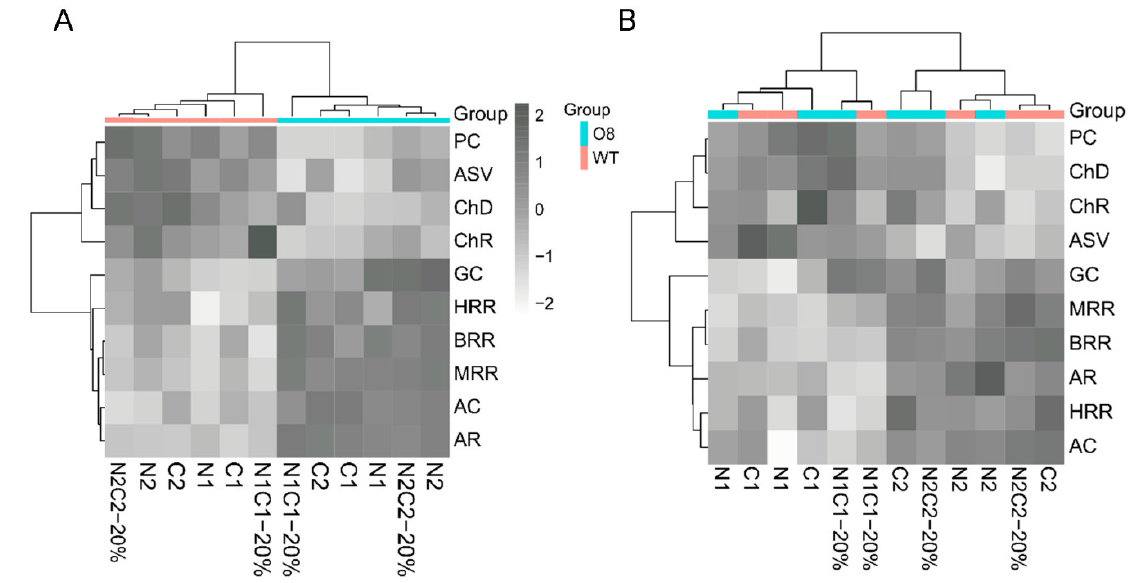
Figure 6. Hierarchical clustering of quality indicators of O8 and WT under different fertilizer treatments. Hierarchical clustering of quality indicators of O8 and WT under different fertilizer treatment in 2019 ( A ) and 2020 ( B ). BRR, brown rice rate; MRR, milling rice rate; HRR, head milling rice rate; AR, aspect ratio; ChR, chalky rice rate; ChD, chalkiness degree; AC, amylose content; PC, protein content; ASV, alkali seeding value; GC, gel consistency.